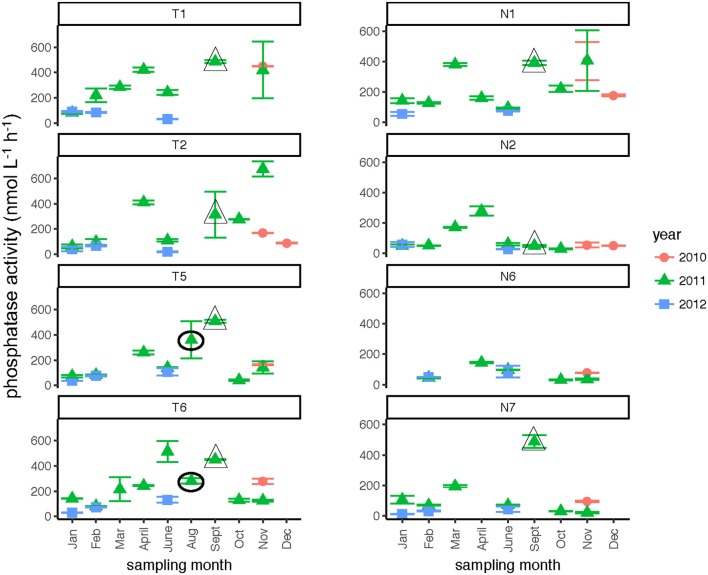
Phosphatase activities (average and standard deviations) at four stations each in the Neuse and Tar-Pamlico Rivers from 2010 to 2012. “T” corresponds to Tar-Pamlico stations, “N” corresponds to Neuse stations. Symbols outlined with triangles show sampling carried out in the month post Hurricane Irene. Circled symbols (Stns. T5 and T6 only) show samples collected in August 2011, shortly after Hurricane Irene crossed through eastern North Carolina.